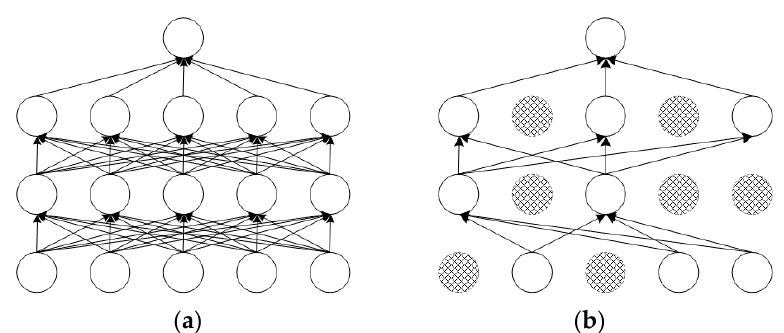
Figure 12. The structure of the dropout model. ( a ) Standard neural network; ( b ) a neural network using dropout.